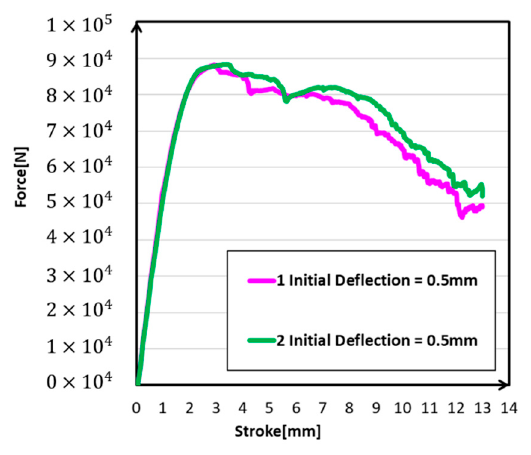
Figure 18. Simulation results: ( a ) Von-Mises (V-M) effective stress of type 1; ( b ) effective plastic strain of type 1; ( c ) V-M effective stress of type 2; ( d ) effective plastic strain of type 2.